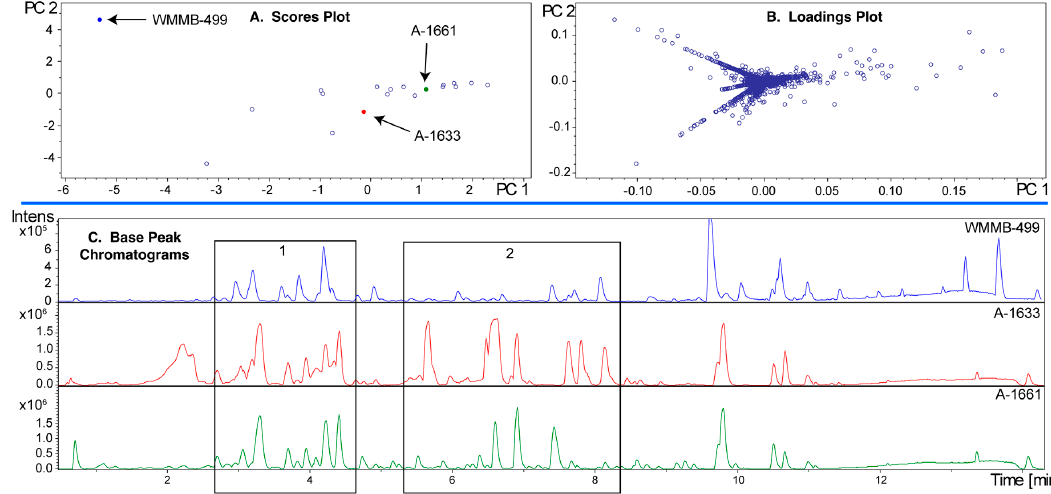
Figure 7. PCA model for Dataset two. ( A ) In contrast to Figure 6A, the scores plot showing PC1 versus PC2 shows that WMMB-499 is unique relative to the other strains; ( B ) Similarly, the loadings plot provides clear evidence for unique molecular features associated with WMMB-499. ( C ) Examples of base peak chromatograms showing that WMMB-499 yielded lower overall ion intensity. Overall, Figures 6 and 7 highlight that the discovery of interesting molecules from a collection of bacterial strains is dependent on the strains analyzed. For our workflow, we analyze Streptomyces